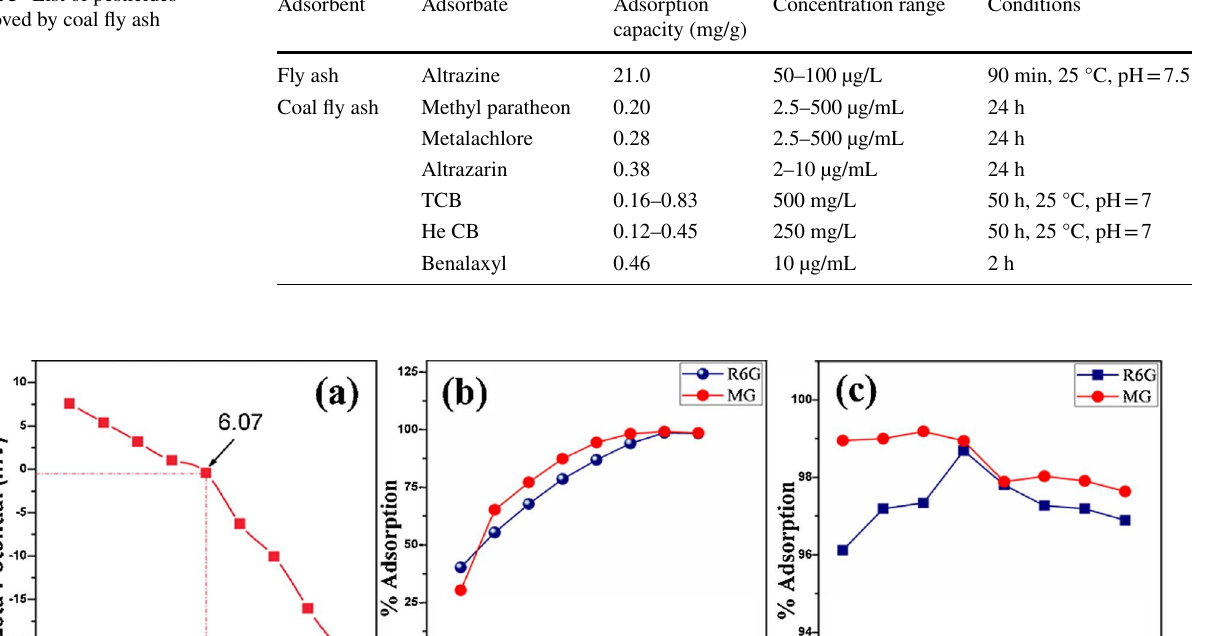
(R6G) and 40 min (MG); Agitation time 105 rpm (MG, r6G) (Dash et al.